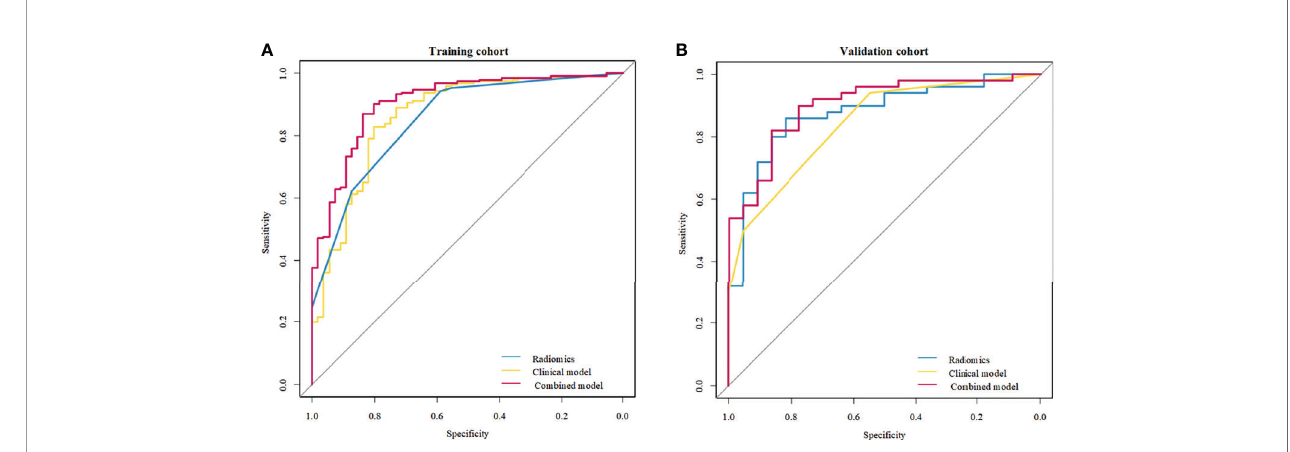
FIGURE 3 | Receiver operating characteristic (ROC) curves of the clinical model, radiomics signature, and combined model to differentiate benign from malignant non-mass enhancement (NME) lesions. (A) Three methods in the training cohort; (B) Three methods in the validation cohort.